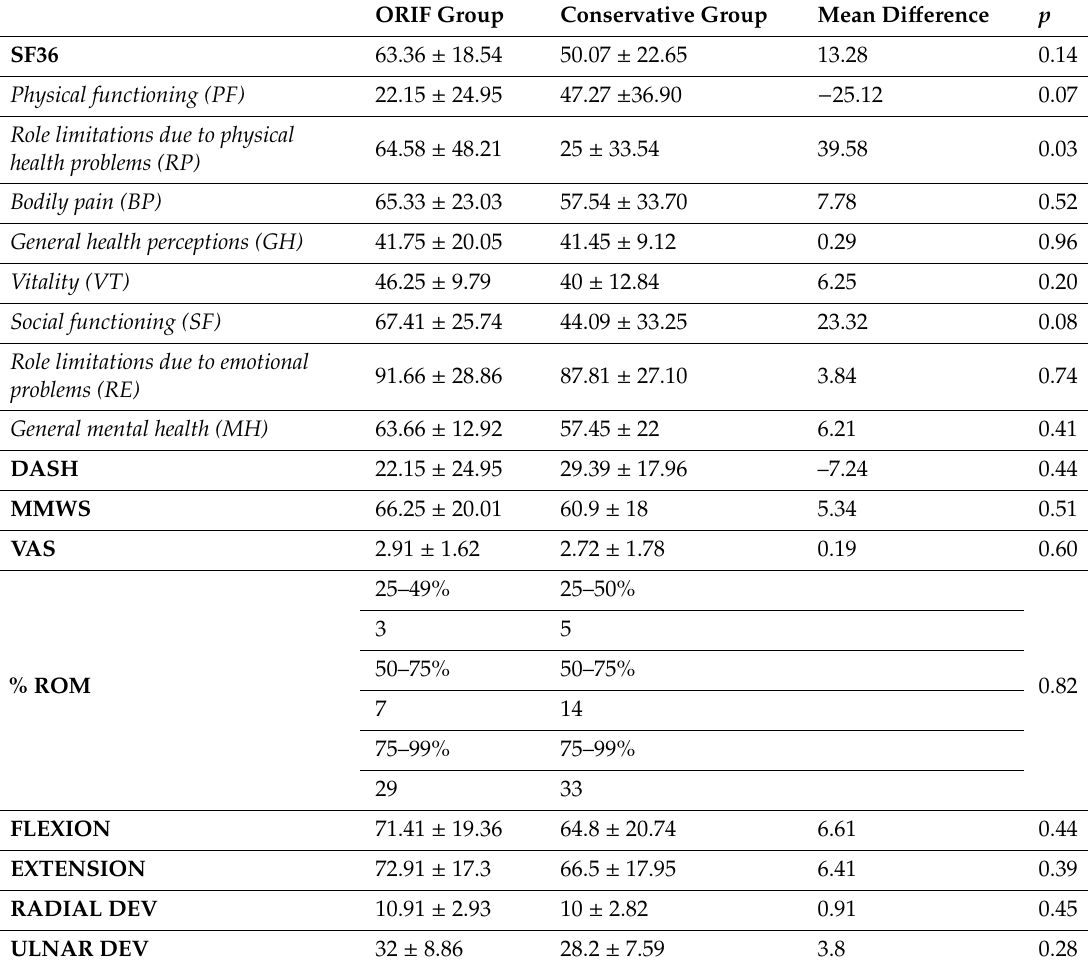
Table 2. Clinical